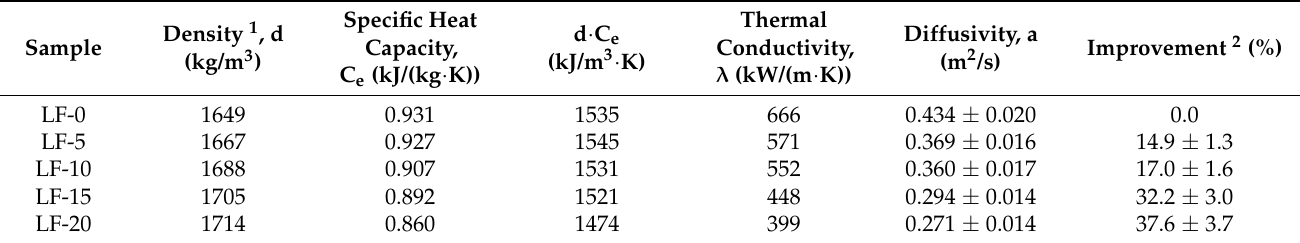
1 The values of density in Table 6 are those shown in Table 3 as apparent density. 2 Improvement calculated using LF-0 as